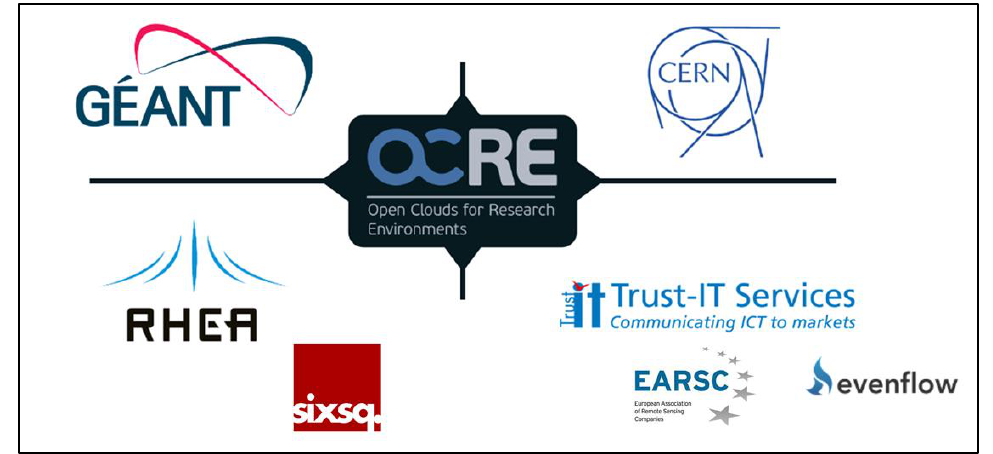
Figure 1. OCRE project and the partners in the